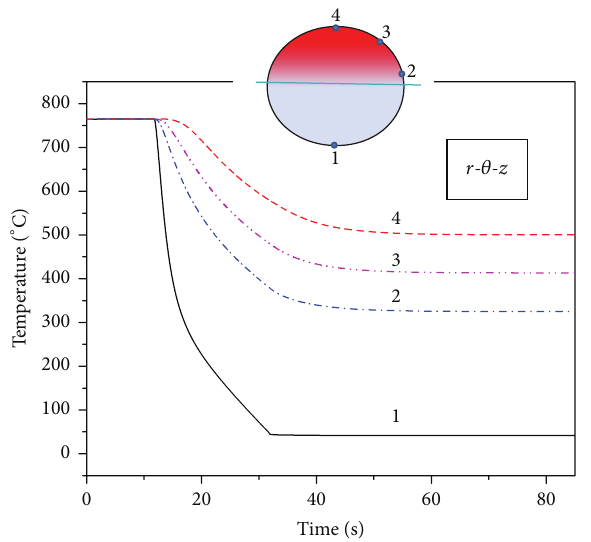
Figure 8: Transient surface temperature along the circumference of fuel pin.